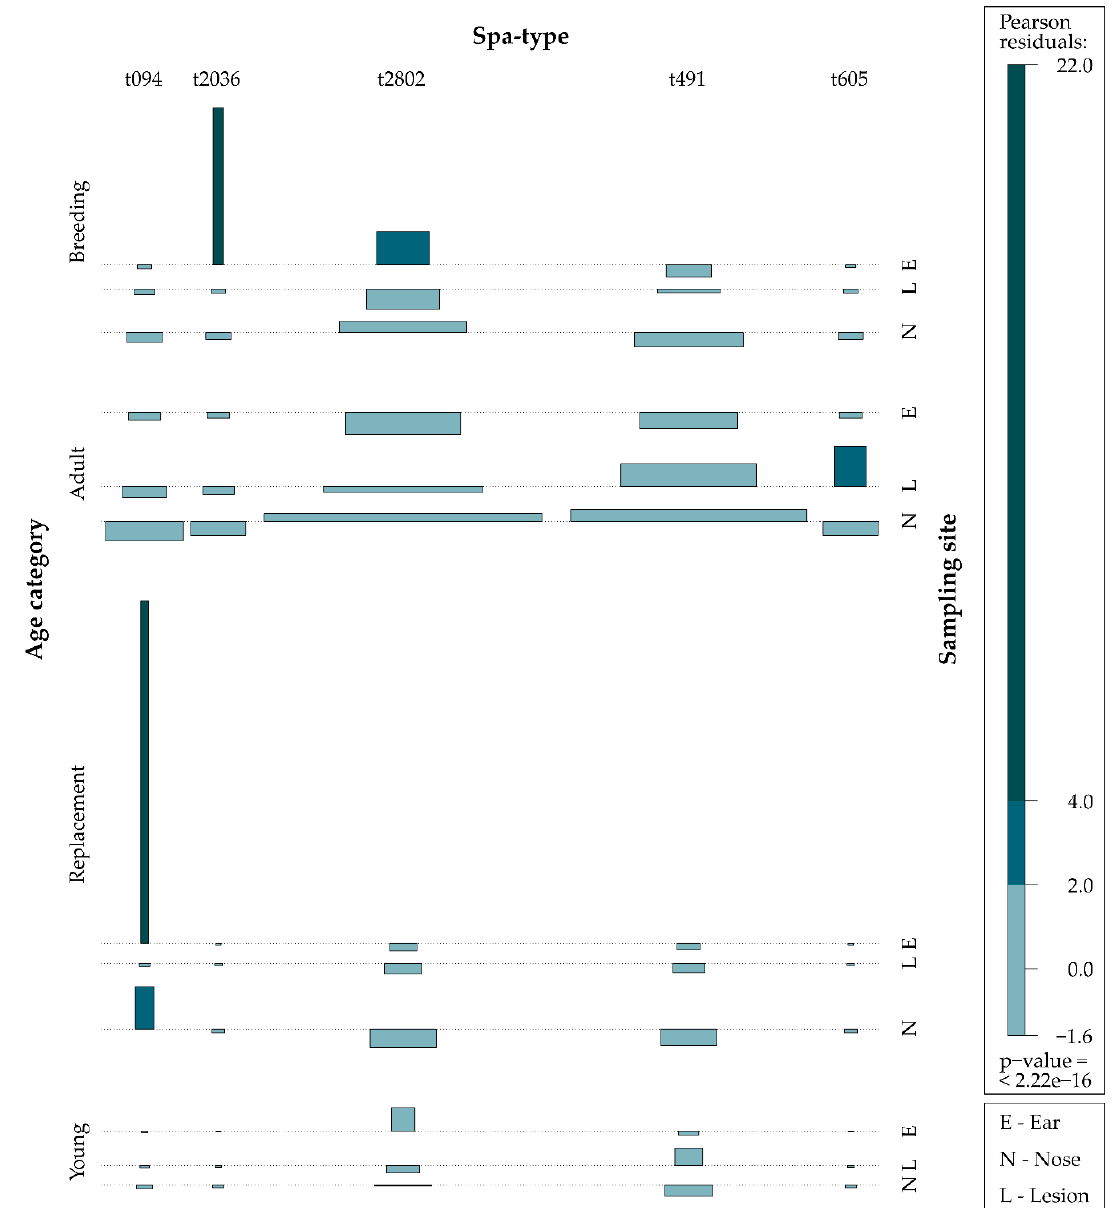
Figure 3. Association between spa ‐ types, sampling site and age category: The association plot shows Pearson residuals comparing age category, spa ‐ type and sampling site. Areas of the rectangles represent the number of observations in each cell. The darker the blue, the stronger the association.